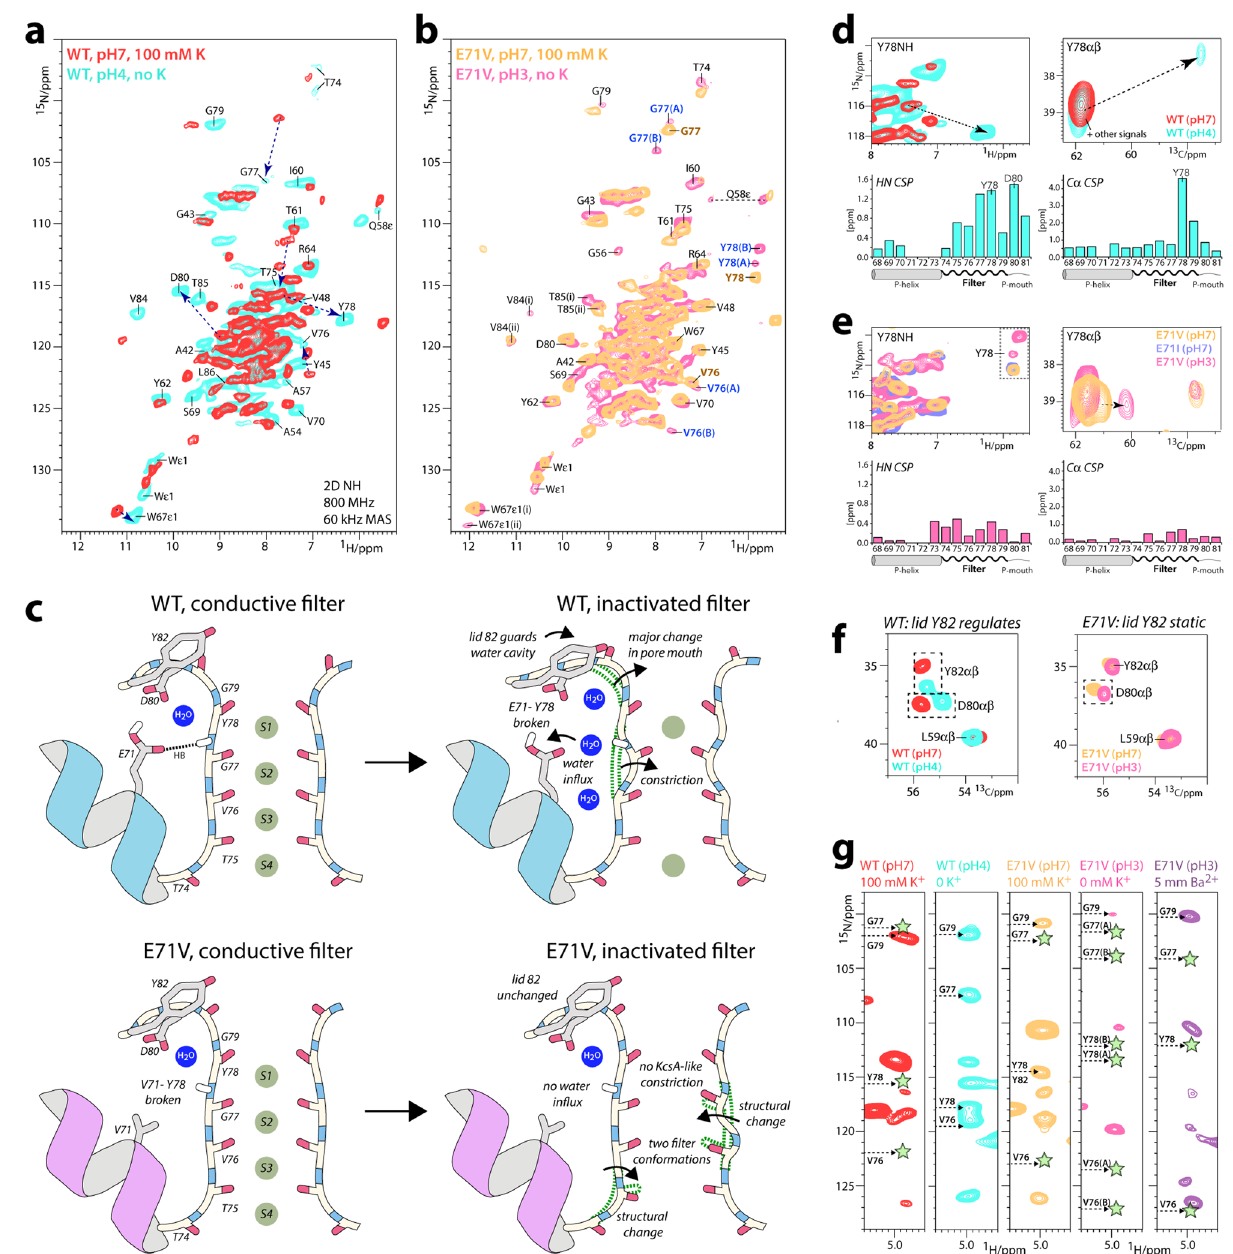
Fig. 3 Comparing inactivation gating by ssNMR. a Superposition of 2D NH ssNMR spectra of ( a ) closed-conductive (red) and open-inactivated (cyan) WT KcsA channels acquired in membranes. Arrows indicate major signal shifts of key residues. b 2D NH spectra of E71V KcsA in closed-conductive (yellow) and open-inactivated (pink) states. The E71V KcsA fi lter shows two conformations A and B , highlighted with blue labels, under inactivation conditions. V76, G77, and Y78 of the canonical conductive fi lter (1K4C) are labeled in brown for clarity. c Schematics of the changes that accompany inactivation in WT and E71V. The inactivated WT fi lter constricts at sites S2 and S3, accompanied by a rupture of the E71 – Y78 interaction and the in fl ux of water into a cavity behind the fi lter. NMR data also reveal major structural changes at the S1 site and the pore mouth. The inactivated E71V fi lter does not constrict like KcsA, does not feature structural water in the cavity, and shows two conformations. d Upper panel: 2D NH and 2D CC spectra of the WT fi lter showing large chemical shift perturbations (CSPs) of key residue Y78 upon constriction. Lower panel: HN and C α CSPs of the open-inactivated state in reference to the closed-conductive state. Source data are provided as a Source Data fi le. e Same as d for E71V, which shows only small CSPs upon inactivation. Source data are provided as a Source Data fi le. f Residue Y82 guards the access to the cavity behind the fi lter. 2D CC spectra show that Y82 undergoes a conformational change upon constriction of the WT fi lter but is static during E71V KcsA inactivation. g 2D N(H)H ssNMR spectra to probe structural water behind the conductive (red) and constricted (cyan) WT fi lter, the conductive (yellow) and inactivated (pink) E71V fi lter, and the barium- bound E71V fi lter (magenta). Green stars mark the absence of structural water.